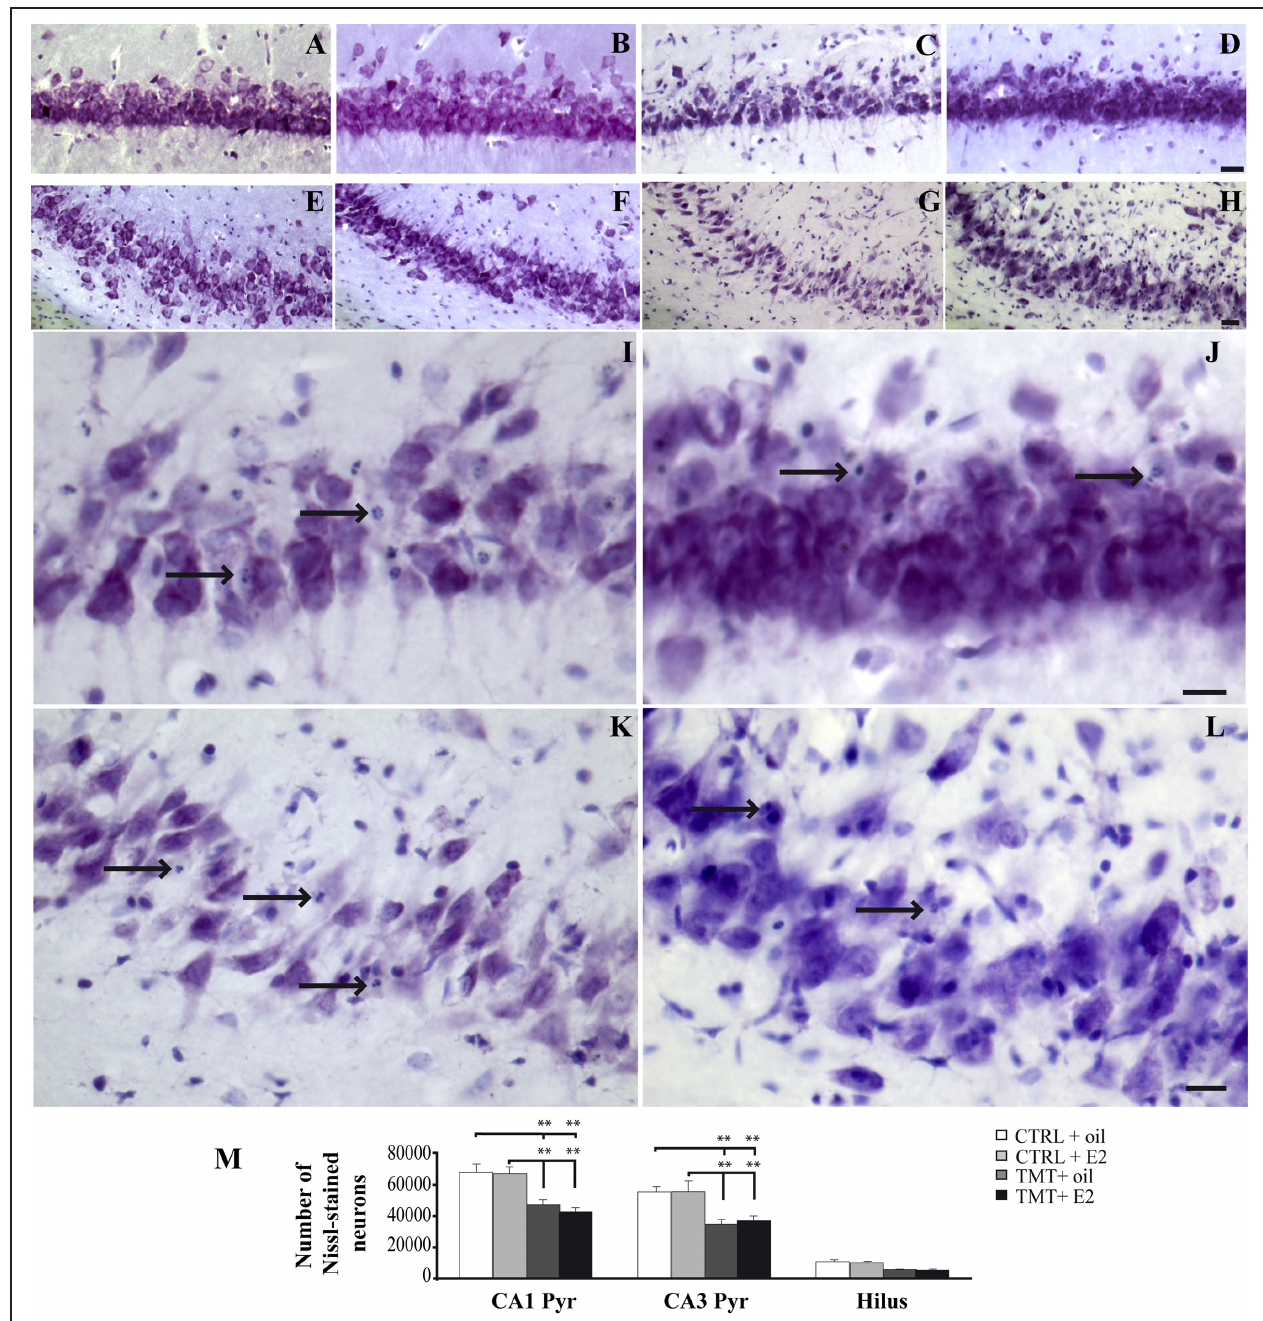
FIGURE 2 | Trimethyltin-induced hippocampal damage. (A–L) Representative micrographs of Nissl-stained rat hippocampal sagittal sections from CA1 (A–D,I,J) and CA3 subfields (E–H,K,L) of CTRL + oil- (A,E) , CTRL + E2- (B,F) , TMT + oil- (C,G,I,K) , TMT + E2- (D,H,J,L) treated rats. Neuronal loss and apoptotic bodies are clearly detectable in CA3 and CA1 pyramidal neurons (arrows in I–L ) of both TMT + oil- (C,G,I,K) and TMT + E2- (D,H,J,L) treated animals. Scale bar: 80 μ m in (A–H) , 40 μ m in (I–L) . (M) Bar graphs indicate quantitative analysis of Nissl-stained neurons in CA1 and CA3 pyramidal cell layer and hilus of the different experimental groups. A significant reduction in the number of Nissl-stained cells is evident in CA1 and CA3 pyramidal layers of both TMT-treated-groups compared with control groups. No differences are detectable between the two groups of TMT-treated rats. The values are given as means ± SE ( ∗∗ p < 0.001).